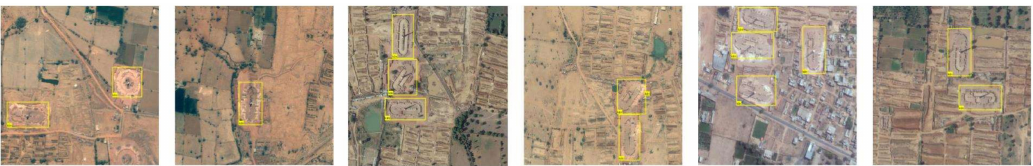
Figure 3. Examples of training samples used in the Faster-RCNN analysis. The yellow rectangles identify kilns in the images. Image data shown from Google Earth provided by Digital